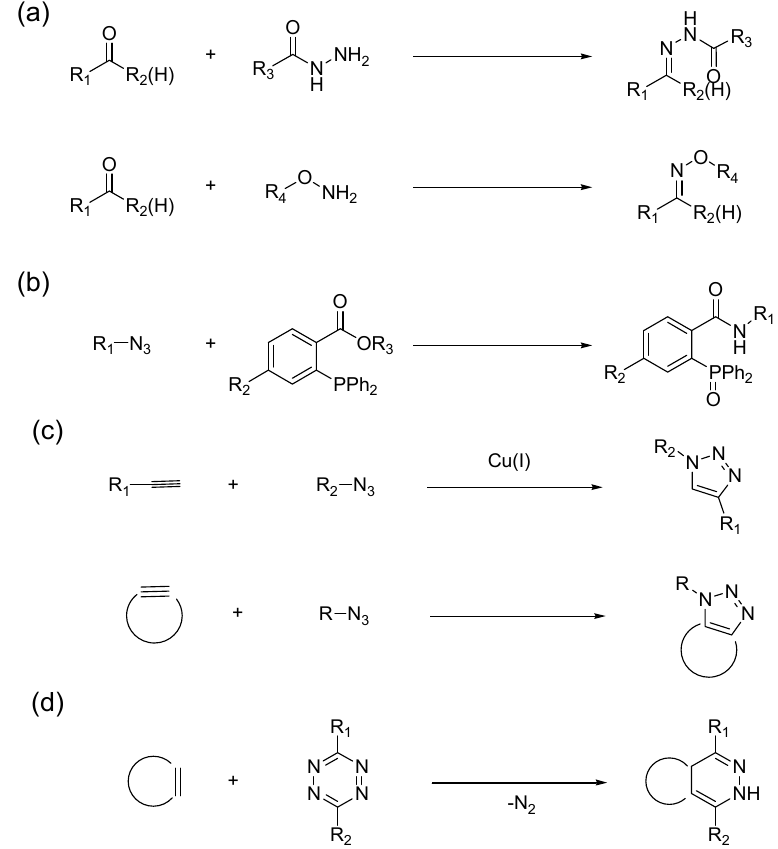
Scheme 1. Examples of bioorthogonal reactions. ( a ) ketone/aldehyde condensation; ( b ) Staudinger reaction; ( c ) 1,3 bipolar cycloaddition; ( d ) Inverse-electron demand Diels-Alder reaction.